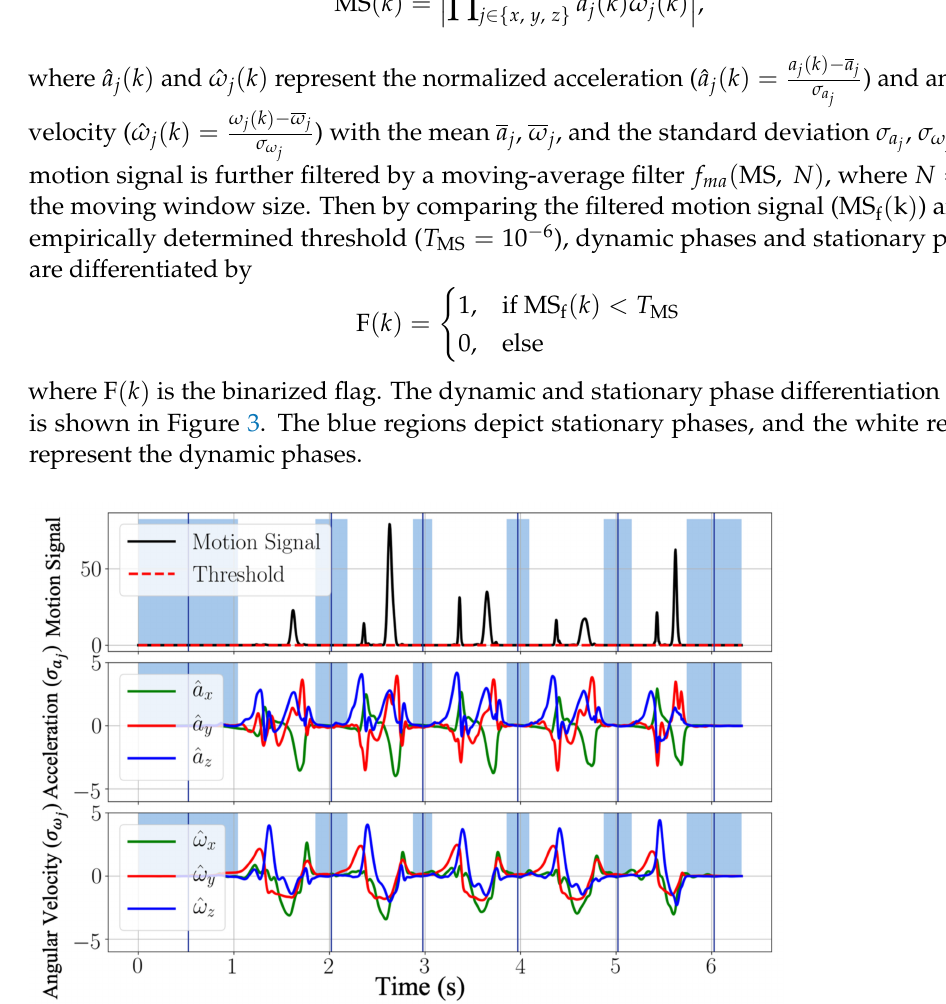
Figure 3. Example signals of motion signals, normalized acceleration, and angular velocity. The threshold for the recognition of the stationary events is calculated by considering the magnitude of the motion signals. The stationary regions are highlighted in